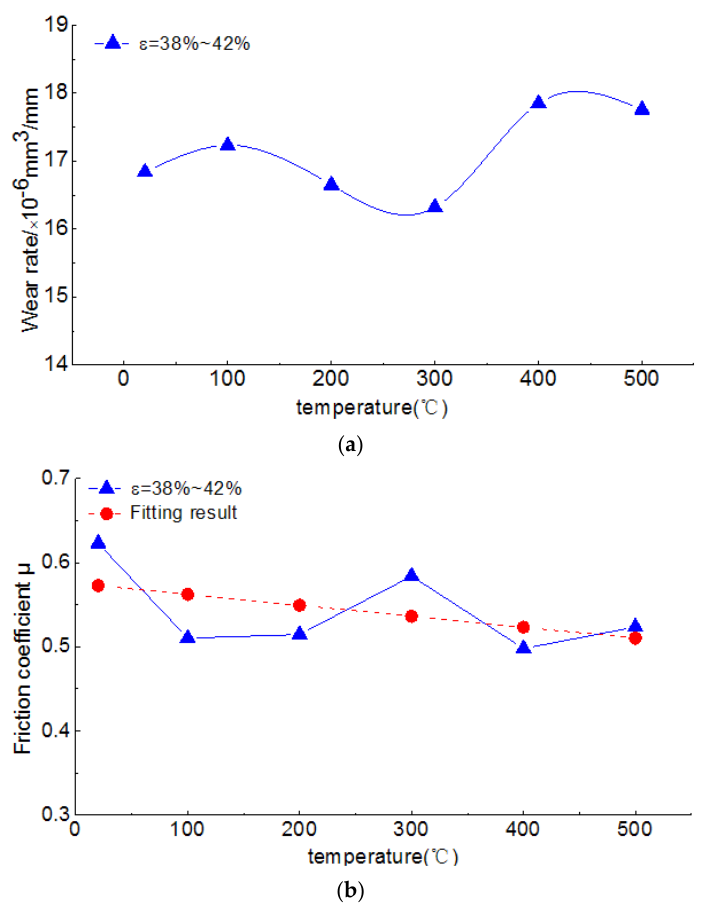
Figure 11. Influence of different temperatures on the wear rate and friction coefficient under the same load and sliding speed: ( a ) relationship between the wear rate and the temperature; and ( b ) experimental and theoretical curves of the friction coefficient at different temperatures.